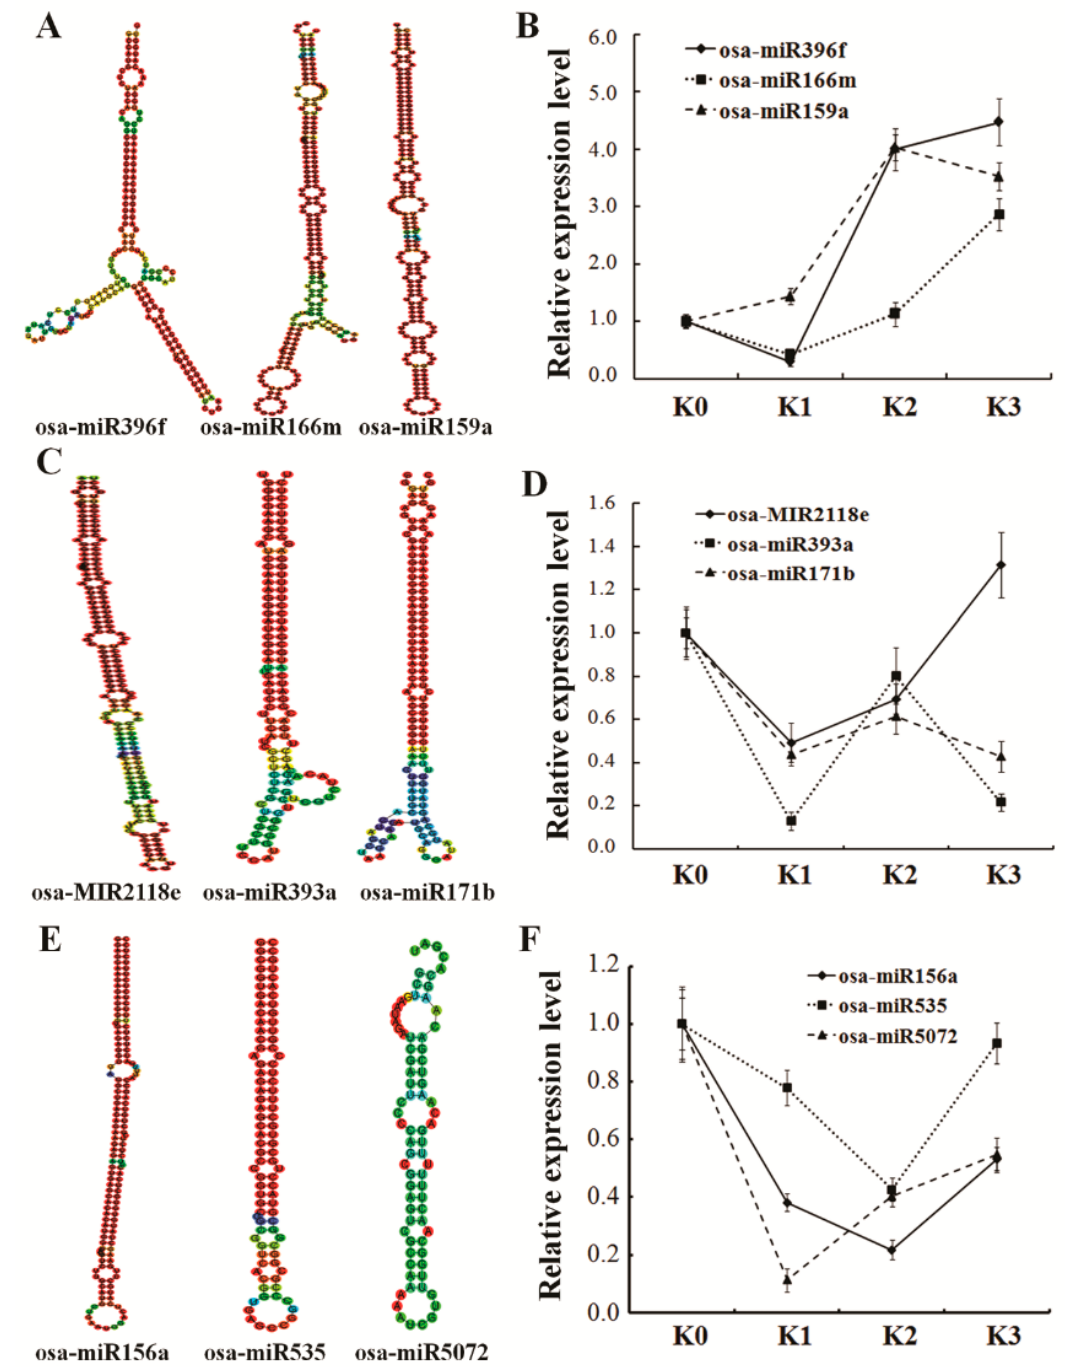
Figure 5. Predicted secondary structures and verification of expression of miRNAs precursor. ( A , C , E ) Predicted secondary structures of nine miRNAs precursor by RNAfold (http://rna.tbi.univie.ac.at//cgi-bin/RNAWebSuite/RNAfold.cgi, 19 March 2018) respectively. ( B , D , F ) The expression of nine miRNAs precursor were tested by qRT-PCR. K0, K1, K2 and K3 represent a resistance rice variety at 0, 6, 12 and 48 hpi respectively. Data represent means of three replicates ± standard deviation for each miRNA in the four miRNAs libraries.